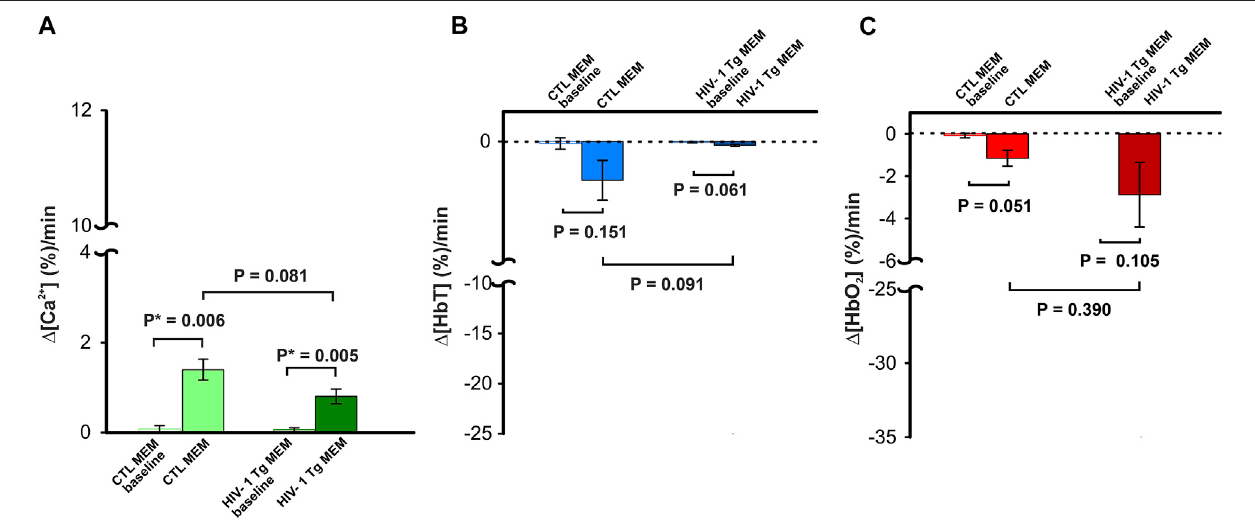
FIGURE 2 | Neuronal Δ [Ca 2+ ] i and brain hemodynamic responses to memantine between control and HIV-1 Tg rats. Memantine increased (A) neuronal Δ [Ca 2+ ] i activity but did not change (B) blood volume ( Δ [HbT]) nor (C) oxygenated hemoglobin ( Δ [HbO 2 ]) in PFC, and these responses did not differ between controls and HIV-1 Tg